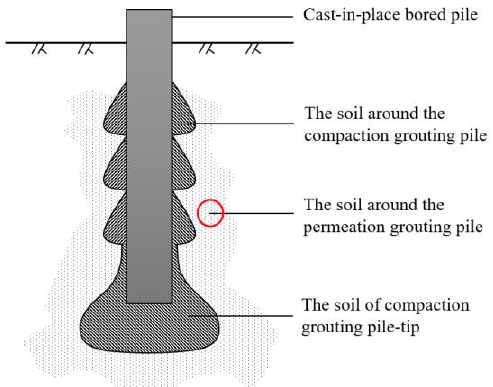
Figure 1. Schematic diagram of post-grouting at pile tip and pile side.